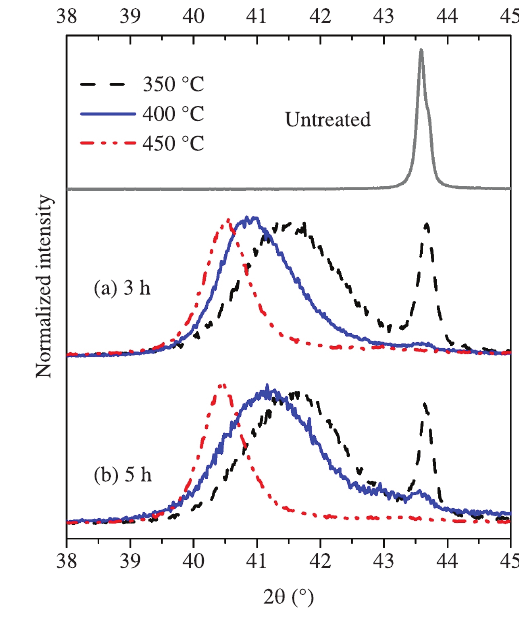
Figure 4. X-ray diffraction patterns of samples untreated and nitrided for 3h at different temperatures.